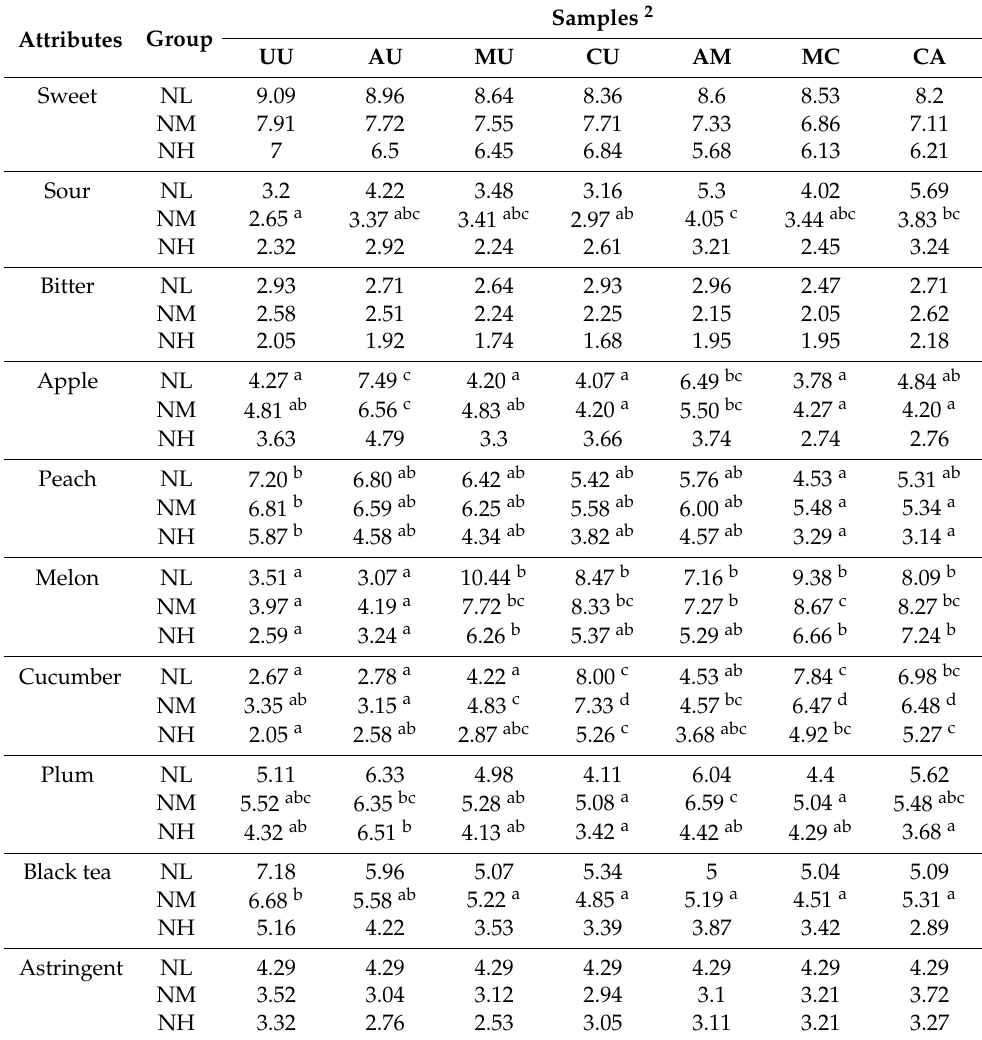
Table 4. Mean intensity scores for sensory attributes 1 of the samples in NL, NM and NH groups. Attributes